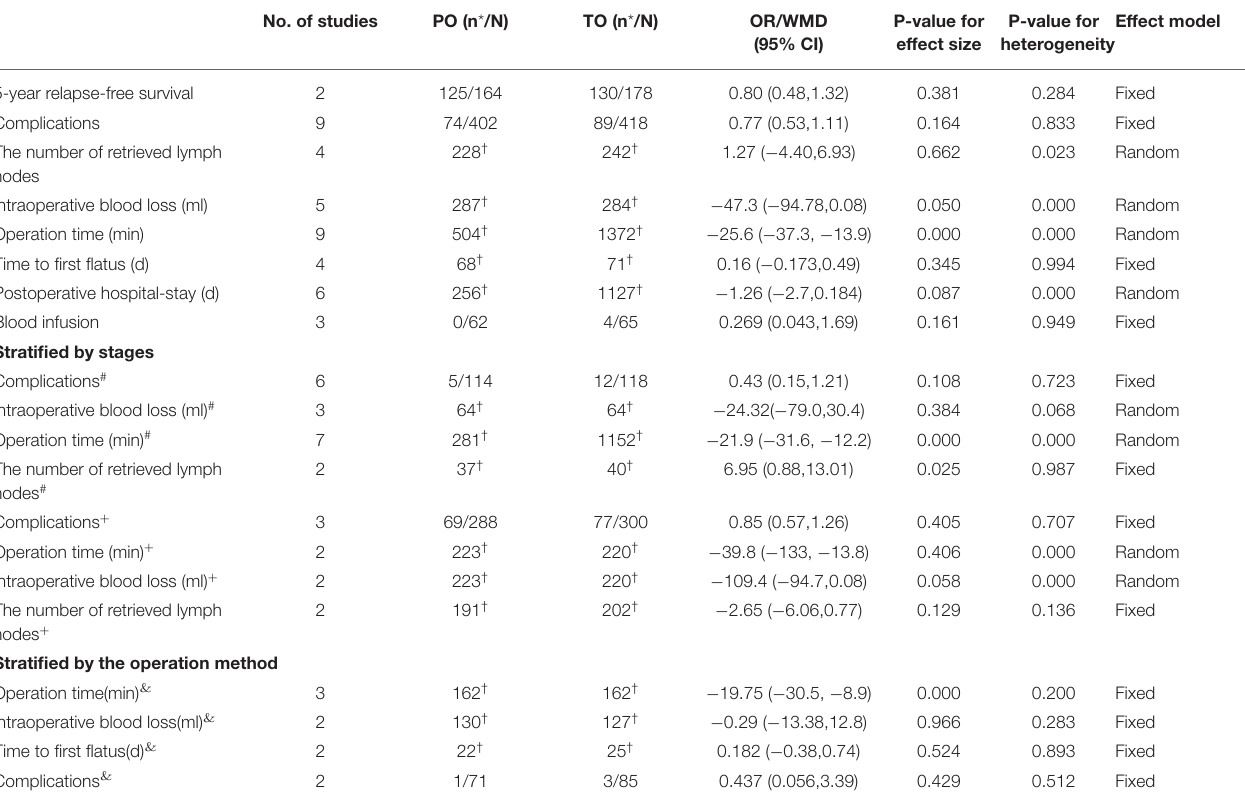
TABLE 2 | Outcome of survival, safety, operation-related events and subgroup analysis stratified by the operation method or